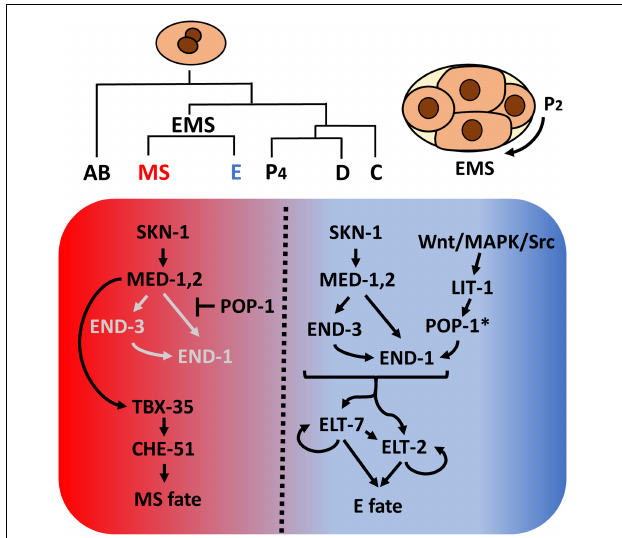
FIGURE 1 | Caenorhabditis elegans founder cells and the endoderm specification network. Asymmetrical cell divisions produce six founder cells, each of which will give rise to specific tissue types. At the four-cell stage, SKN-1 activates the med-1,2 genes, initiating mesendoderm specification. Redundant Wnt/MAPK/Src signaling arising from the neighboring P 2 cell polarizes EMS. In the anterior, un-signaled end, POP-1 represses end-1 and end-3 expression while MED-1,2 turn on tbx-35 , which in turn specify mesoderm MS fate. In the posterior end, LIT-1 kinase, in response to P 2 signals, phosphorylates POP-1 (indicated by *), converting it from a repressor to an activator of endoderm E fate. The two differentiation factors, ELT-7 and ELT-2, once activated, maintain their own expression through autoregulation and regulate thousands of gut genes. In E, Wnt signaling further represses tbx-35 expression (Broitman-Maduro et al., 2006).